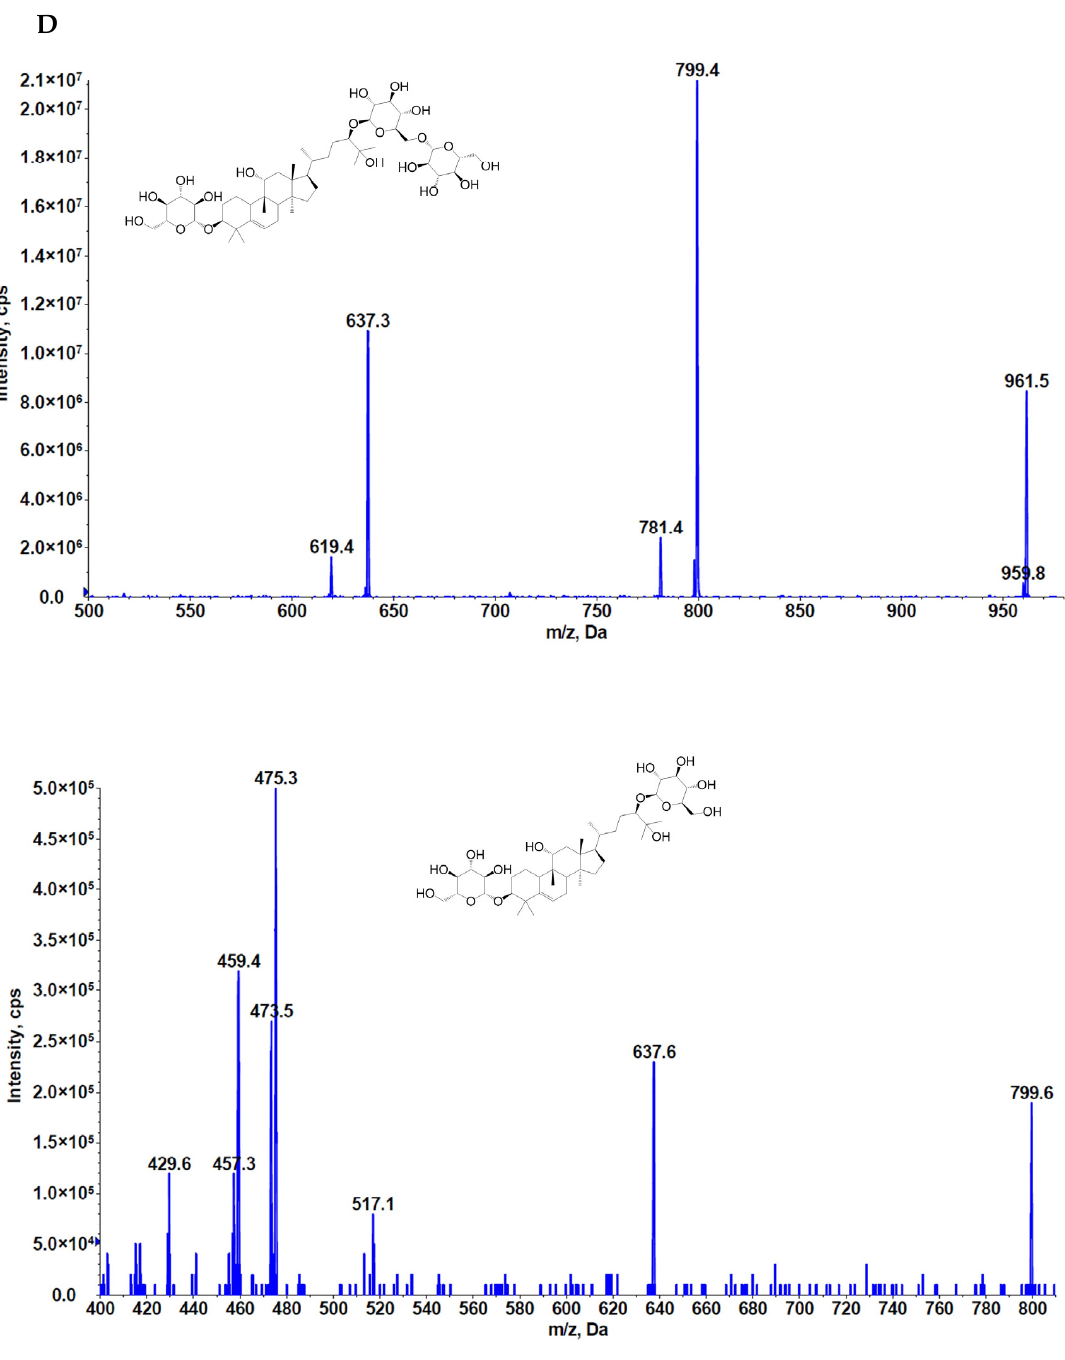
Figure 4. Production of mogrosides in transgenic tobacco lines. ( A ) HPLC-MS/MS analysis of MIII and MII-E in transgenic tobacco lines. ( B ) Accumulation of MIII in transgenic tobacco lines. ( C ) Accumulation of MII-E in transgenic tobacco lines. n.d., not detected. The data are presented as the mean values ± SDs, n = 3 biologically independent samples. The black arrows indicate the peak of MIII and MIIE. ( D ) Full-scan product ion of MIII and MII-E.5.0 × 10 4 .